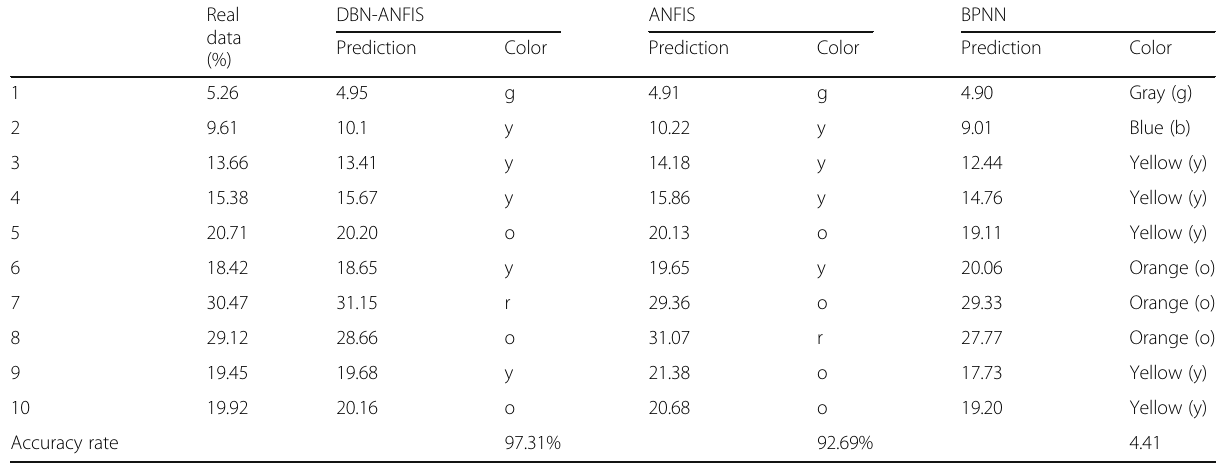
Table 3 The MAPE value of the DBN-ANFIS, ANFIS, and BPNN models Real